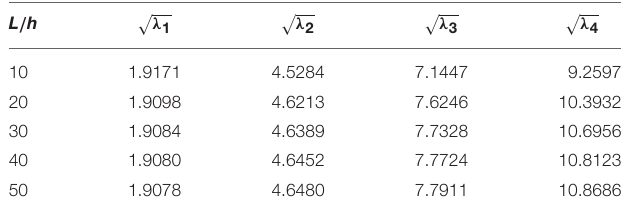
TABLE 20 | Frequency parameters length-to-height ratio. L / h